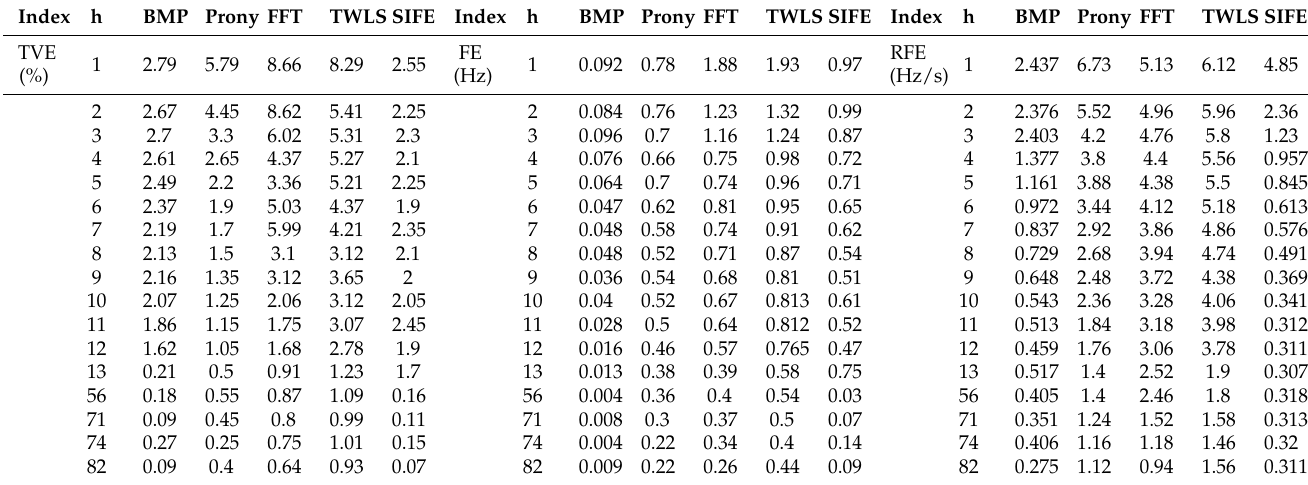
Table 1. Comparison of estimation accuracy among